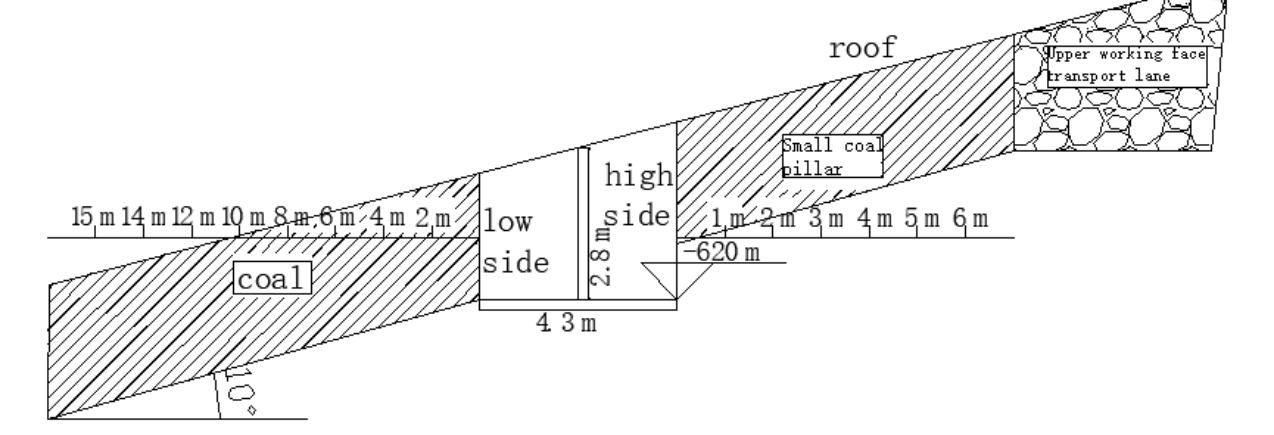
Figure 1. 11318 Schematic diagram of section layout of measuring station.